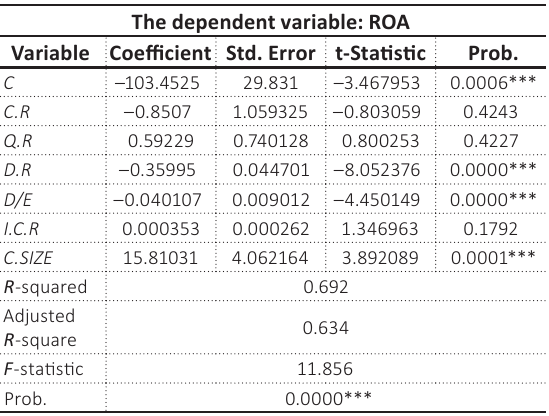
Table 5. Results of H01-1–H01-3 testing